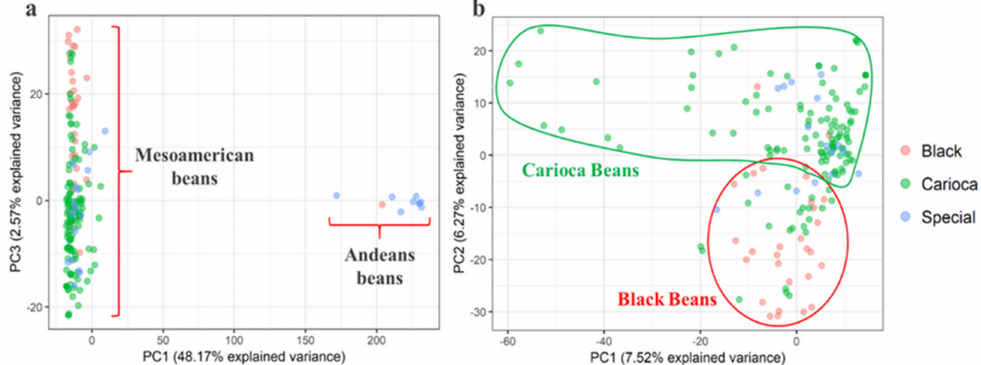
Figure 2. ( a ) Principal component analysis based on the 2827 SNPs for the total set ( n = 185) ( b ) and on only the Mesoamerican accessions ( n =